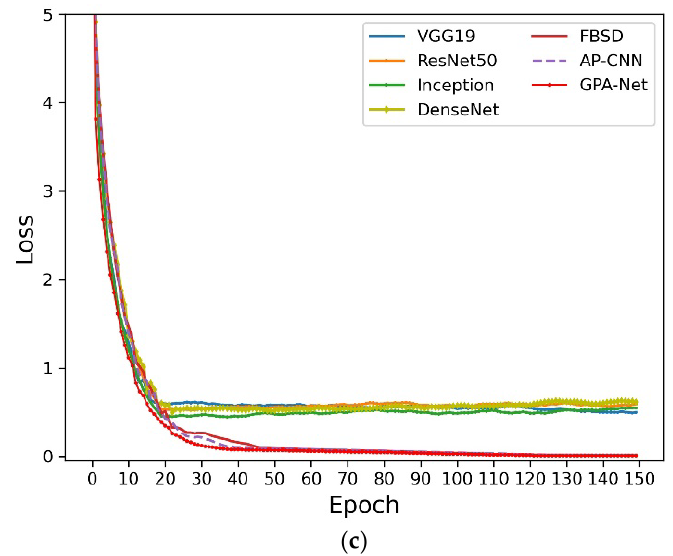
Figure 5. ( a ) The loss curves of each model on CUB‑200‑2011. ( b ) The loss curves of each model on Bird‑400. ( c ) The loss curves of each model on AF‑bird50.